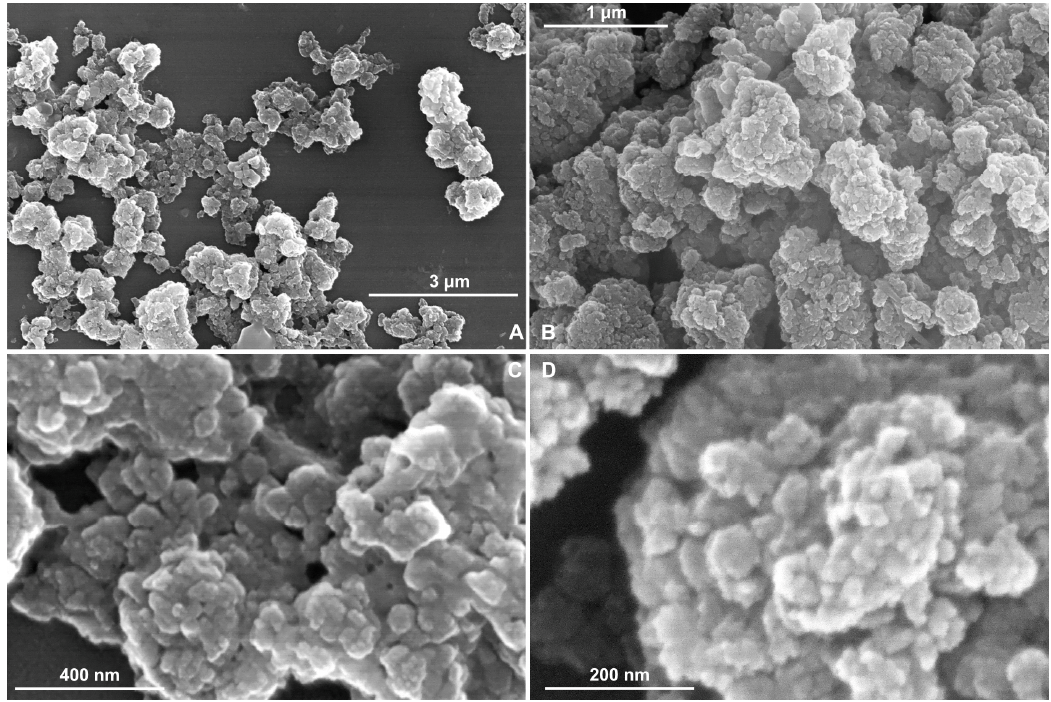
Figure 2. SEM images of TiO 2 sample at different magnifications ( A ) 50,000 × ; ( B ) 100,000 × ; ( C ) 150,000 × ; ( D ) 250,000 ×